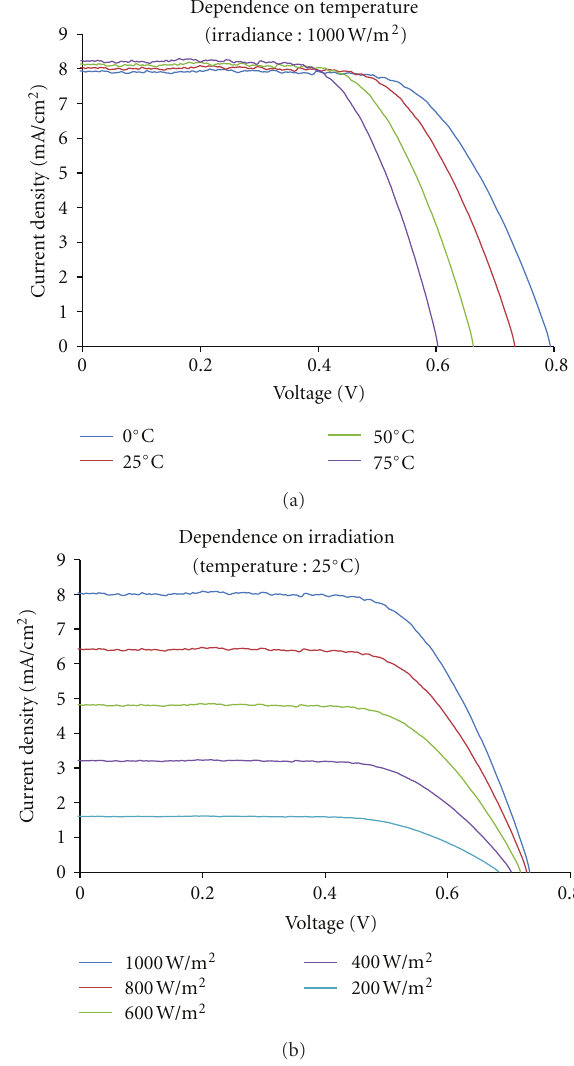
Figure 3: (a) The I - V characteristic curves of DSSCs according to the temperature. (b) The I - V characteristic curves of DSSCs according to the